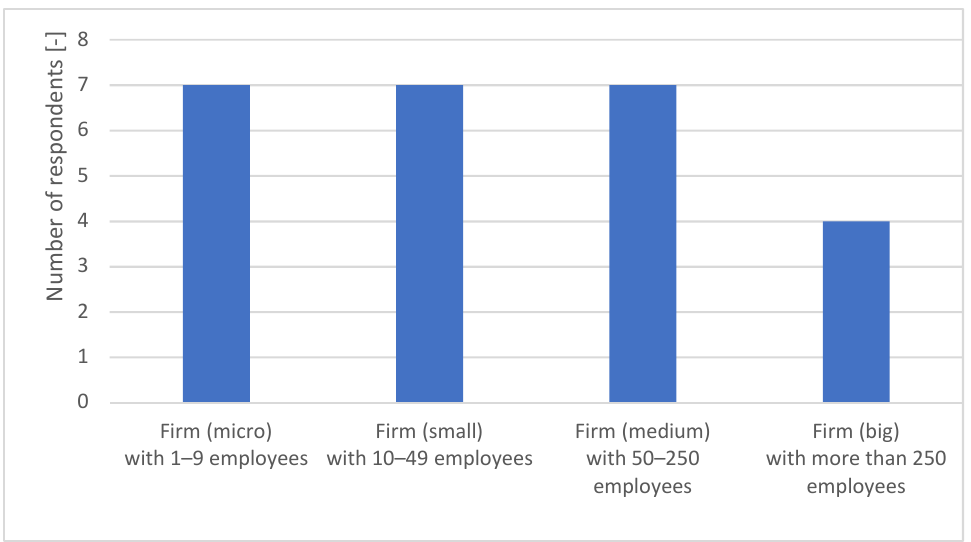
Figure 4. The ratio of companies with implemented open innovations to those not implemented.